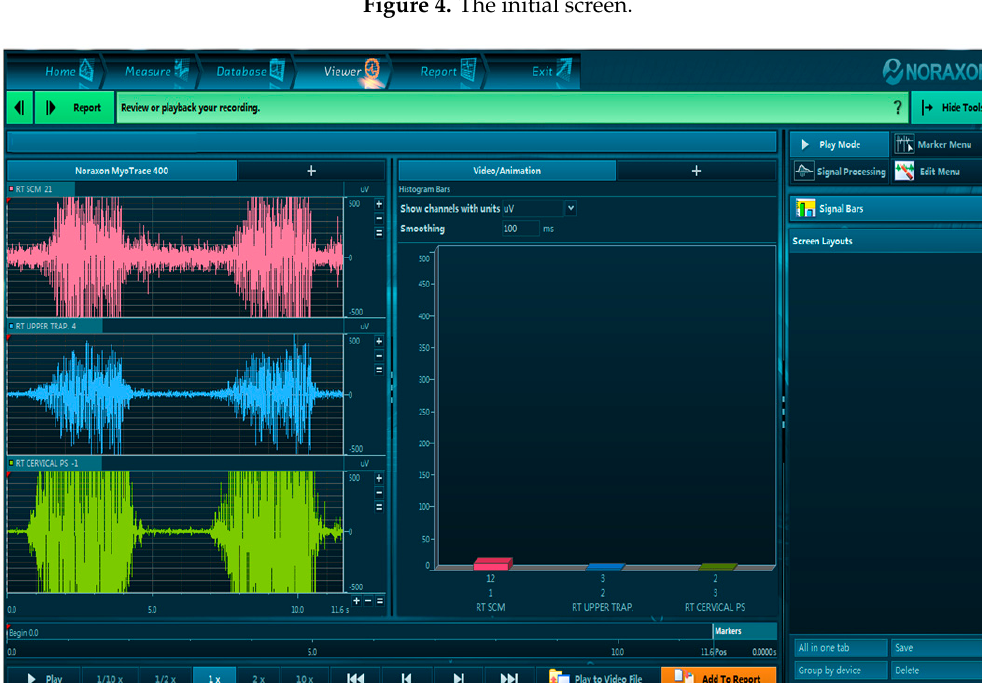
Figure 5. Surface EMG signal screen.